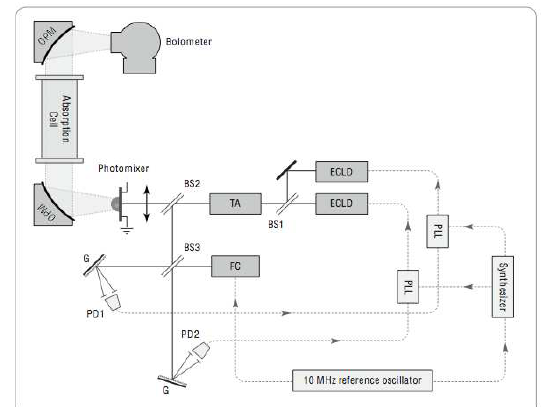
Fig. 1. Experimental setup of the synthesised THz source. A first beam splitter (BS1) is used to overlap the two laser beams from the two External Cavity Diode Laser (ECDL) and seed them to Tapered Amplifier (TA). At the output, optical beat note is divided by a second beam splitter (BS2). A first part is used to produce the THz radiation collected at the backside of the photomixer by a silicon lens. Two Off axis Parabolic Mirrors (OPM) are used to collimate and focus the THz beam through an absorption cell to a cryogenic bolometer. The frequency comb (FC) is overlap with optical beat note by means of a third beam splitter (BS3). Two grating (G) disperse the FC and two lasers to ensure an heterodyne measurement between each ECDL and FC detected by two different photodiodes (PD1- PD2). The heterodyne signals are feed to two Phase Lock Loop (PLL) to synthesized the difference frequency between two ECDL to a synthesizer. A 10 MHz crystal oscillator is used as reference signal for synthesizers, counters and spectrum analyzers required. Solids lines show optical signal, and dashed lines indicate electronic signal.